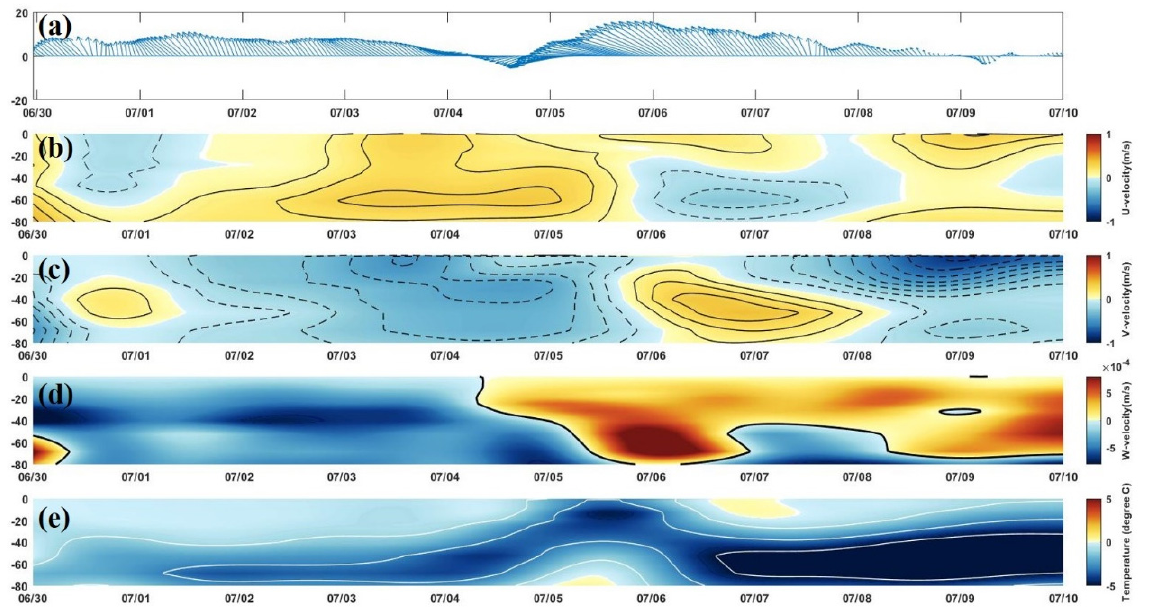
Figure 12. Evolution of wind forcing (vectors), u, v, w components of velocity fields (units, u: ms − 1 , v: ms − 1 , w: 10 − 4 ms − 1 ) and temperature ( ◦ C, color shading) are shown in panels from top to bottom ( a – e ). Model fields were sampled at 25.08 ◦ N, 122 ◦ E, which was chosen in reference to where maximum sea surface cooling occurred. Positive values (contours in solid lines) in velocity fields correspond to eastward and northward flows for u and v, respectively. Contours in dashed lines in the u and v fields denote negative, westward, and southward velocities, respectively.